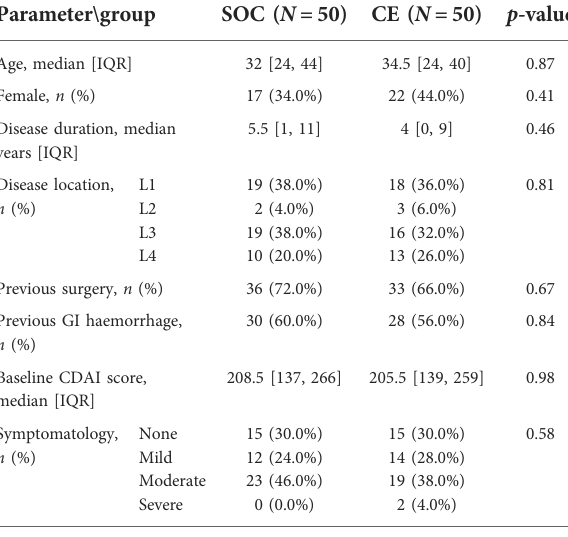
TABLE 1 Patient groups after